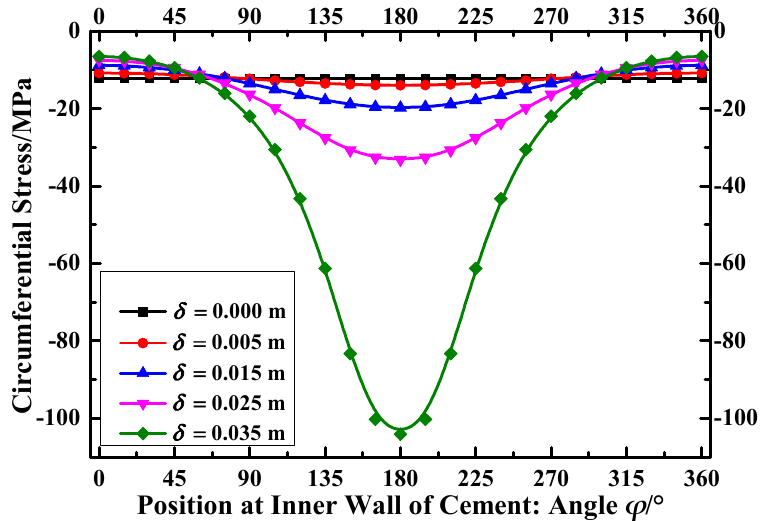
Figure 11. Variation of circumferential stress with azimuth angle φ for different eccentricities.